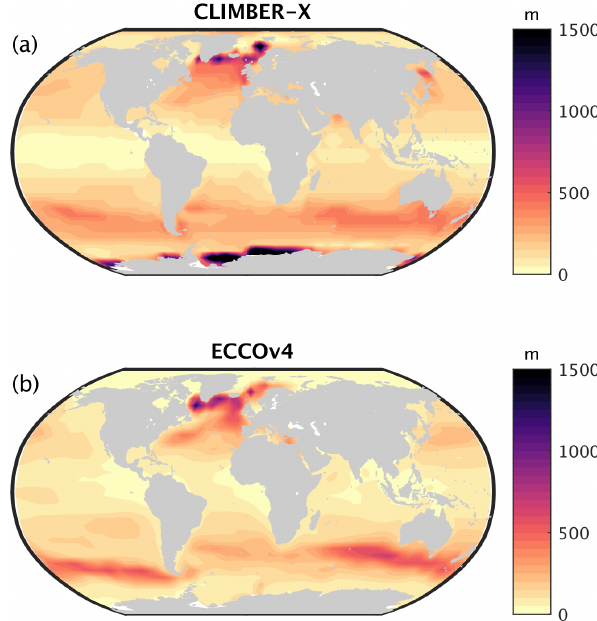
Figure 11. Simulated ocean overturning circulation: (a) global and (b) Atlantic.